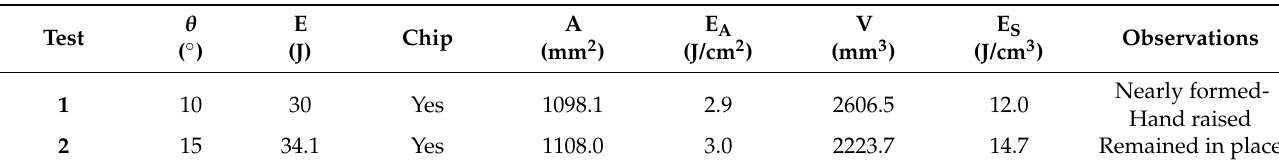
Table 5. Summary of optimum energy calculation tests. (The precision of the measures is of 0.5 ◦ for θ , and 5 mm for the scanner).